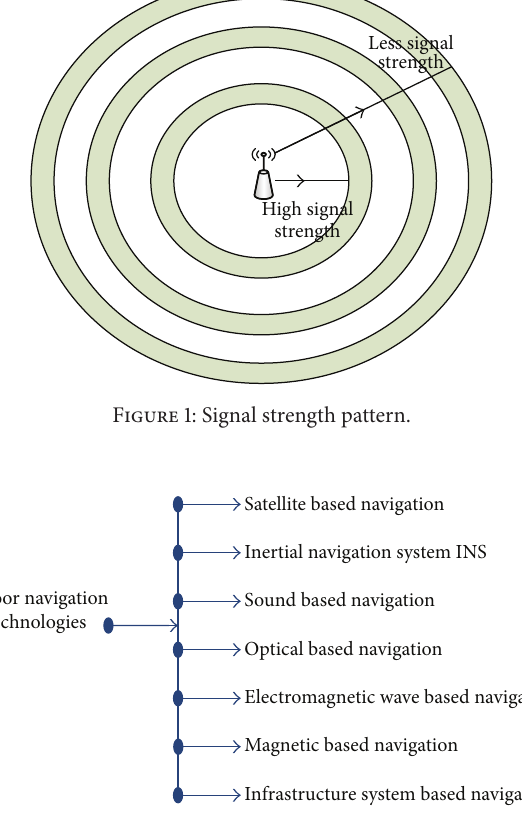
Figure 2: Indoor navigation